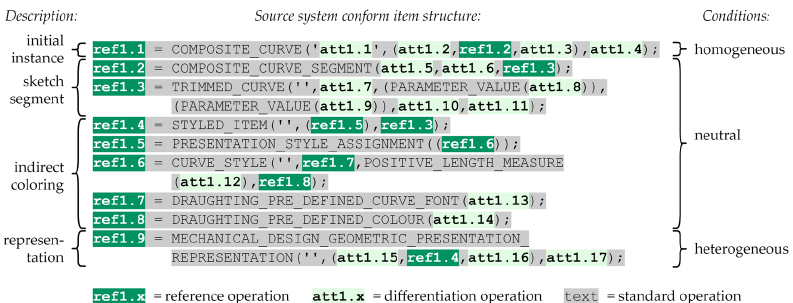
Figure 8. Source system (Creo) conforms to the item structure of the sketch coloring.